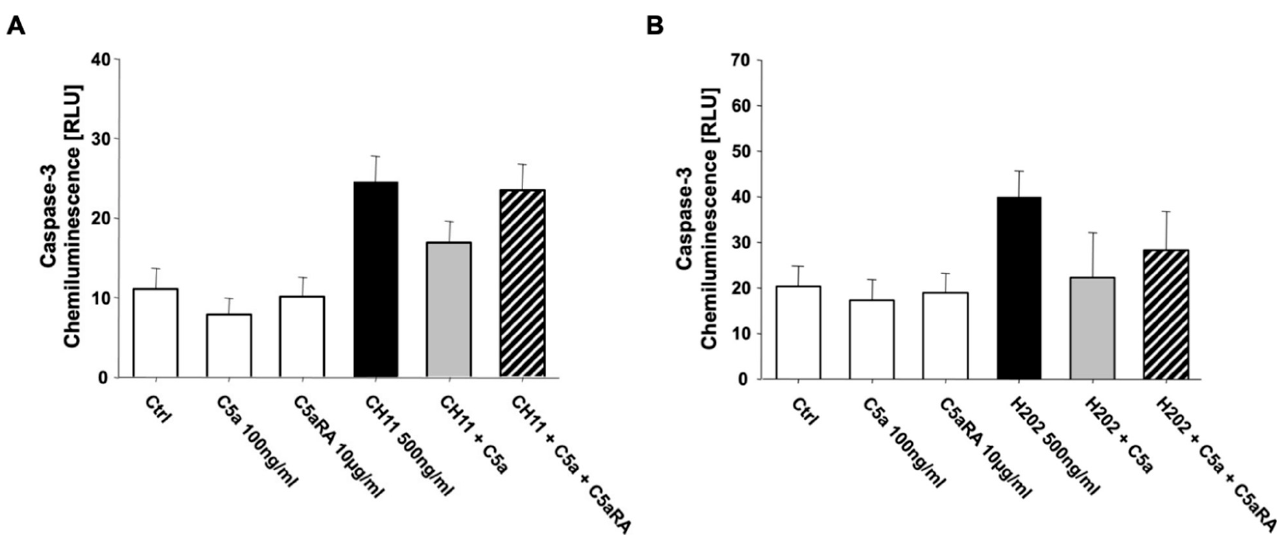
Figure 5. Caspase-3 activity measured by a chemiluminescence assay of ( A ) extrinsic CH11- ( n = 3) as well as ( B ) intrinsic H 2 O 2 -induced apoptosis in freshly isolated PMN from healthy male volunteers ( n = 3). C5aRA = C5aR1 specific small peptide inhibitor PMX53. Results are shown as mean ± SEM. * = p < 0.05.